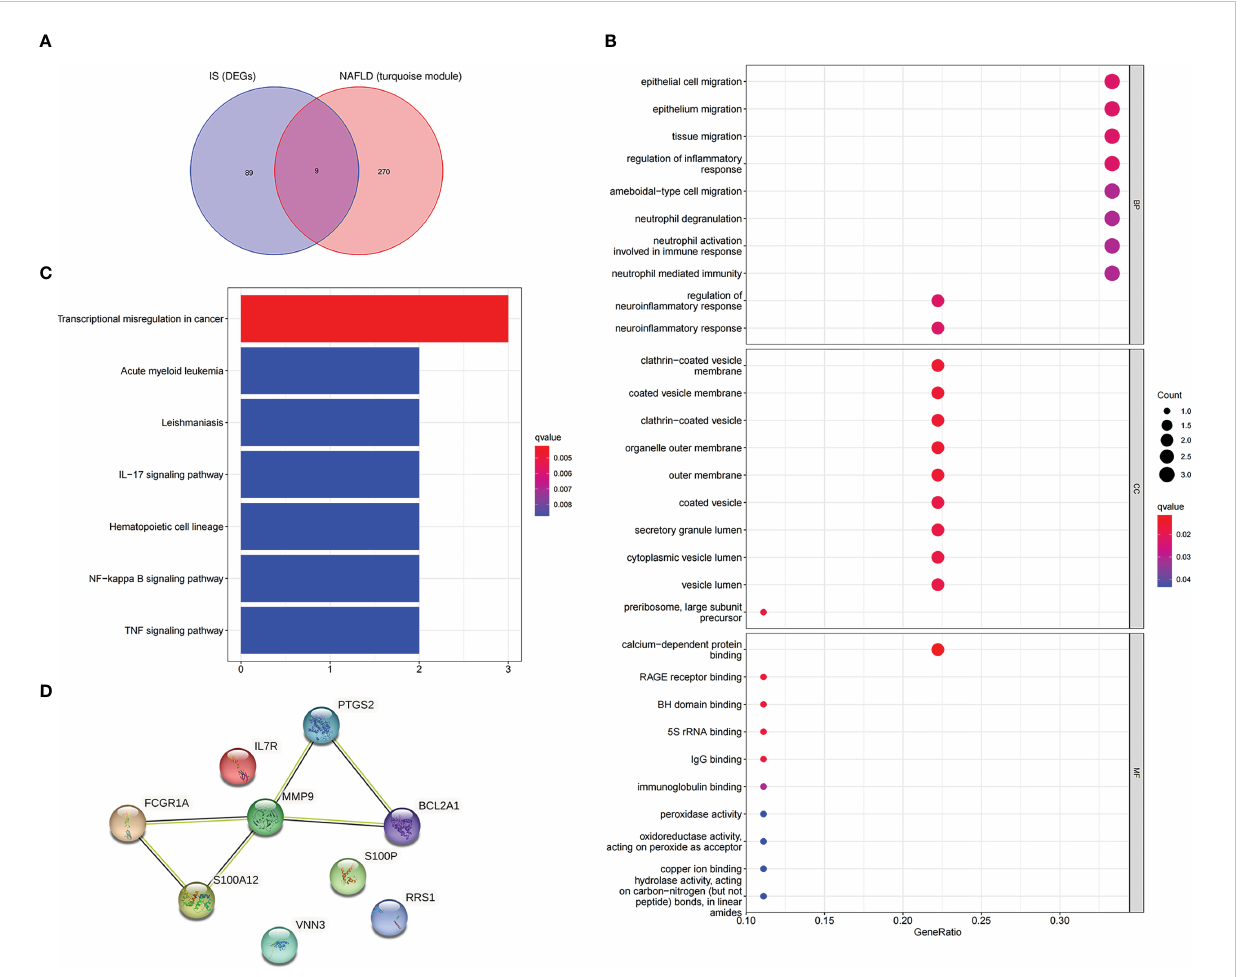
FIGURE 6 Enrichment analysis and the PPI network of the intersection genes of NAFLD and IS. (A) The Venn diagram depicts the 9 intersection genes in the turquoise module of NAFLD and the DEGs of IS. (B) GO enrichment analysis of 9 intersection genes. (C) KEGG analysis of 9 intersection genes. (D) The PPI network illustrates the interactions among the 9 intersection